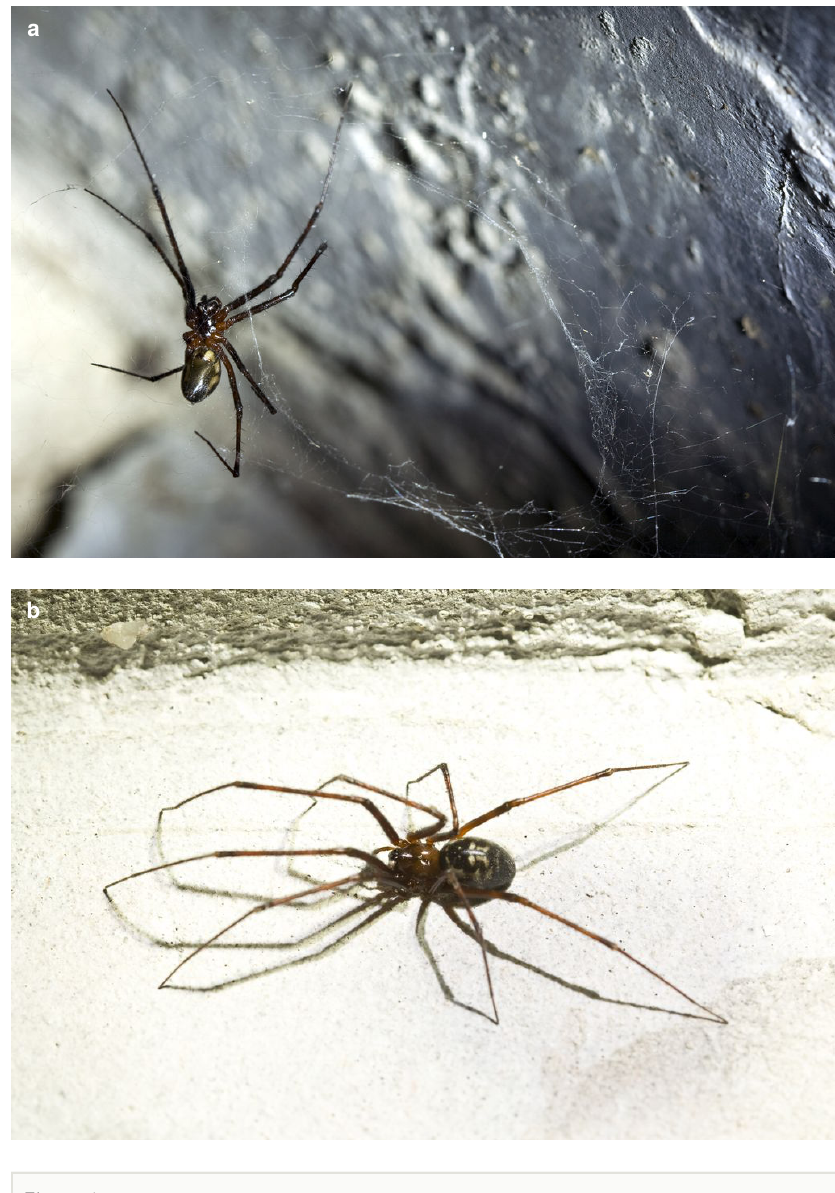
Figure 1. Pimoa delphinica , female from the military bunker near Castelfel fi no, Province of Cuneo, Italy. [Photo credit: Alessandro Girodo] a : Ventral habitus. b : Dorsal